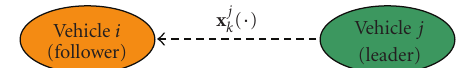
Figure 1: The delay-free intervehicle communication between two